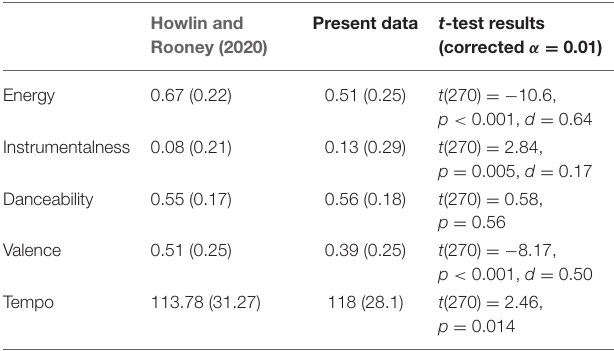
TABLE 2 | Comparison of means and standard deviations for Howlin and Rooney (2020), and the present data, with associated t -tests. Howlin and Rooney